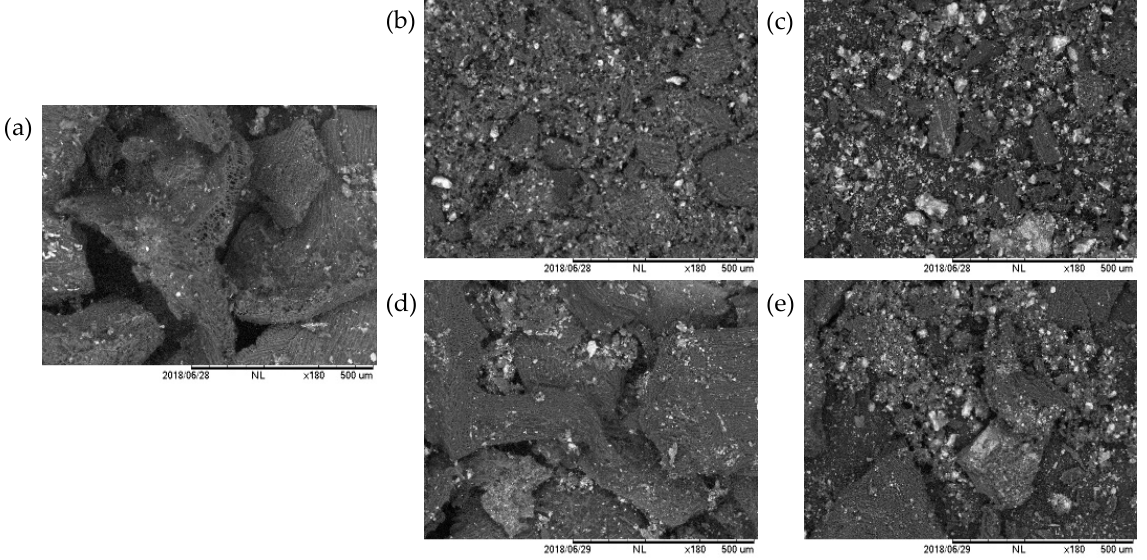
Figure 1. SEM images of: ( a ) AC, ( b ) ACCoTi5, ( c ) ACCoTi10, ( d ) ACFeTi5, and ( e ) ACFeTi10. The grey areas refer to the carbonaceous matrix [4] while light grey areas can be assigned to the mineral fraction (TiO 2 and ash) in AC [64]. On the other hand, an increase of light grey areas from AC to the one with the highest percentage of Fe-TiO 2 or Co-TiO 2 doping is observed. To quantify this increase, a binarization strategy of the images is carried out to isolate the whiter fraction in the SEM images (Section 3.4.5).